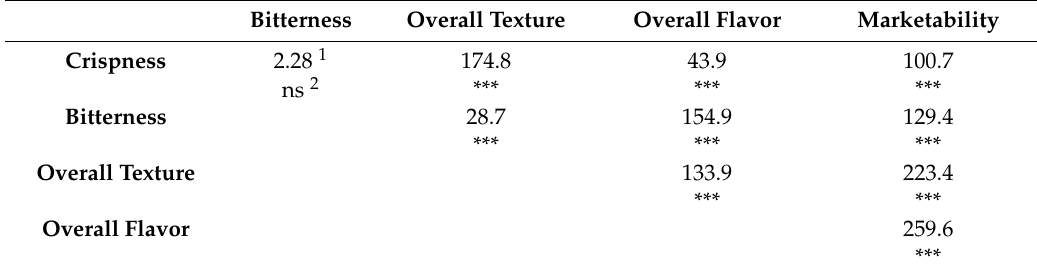
Table 5. Correlations between sensory criteria for greenhouse-grown lettuce from a sensory evaluation conducted by 50 untrained consumer